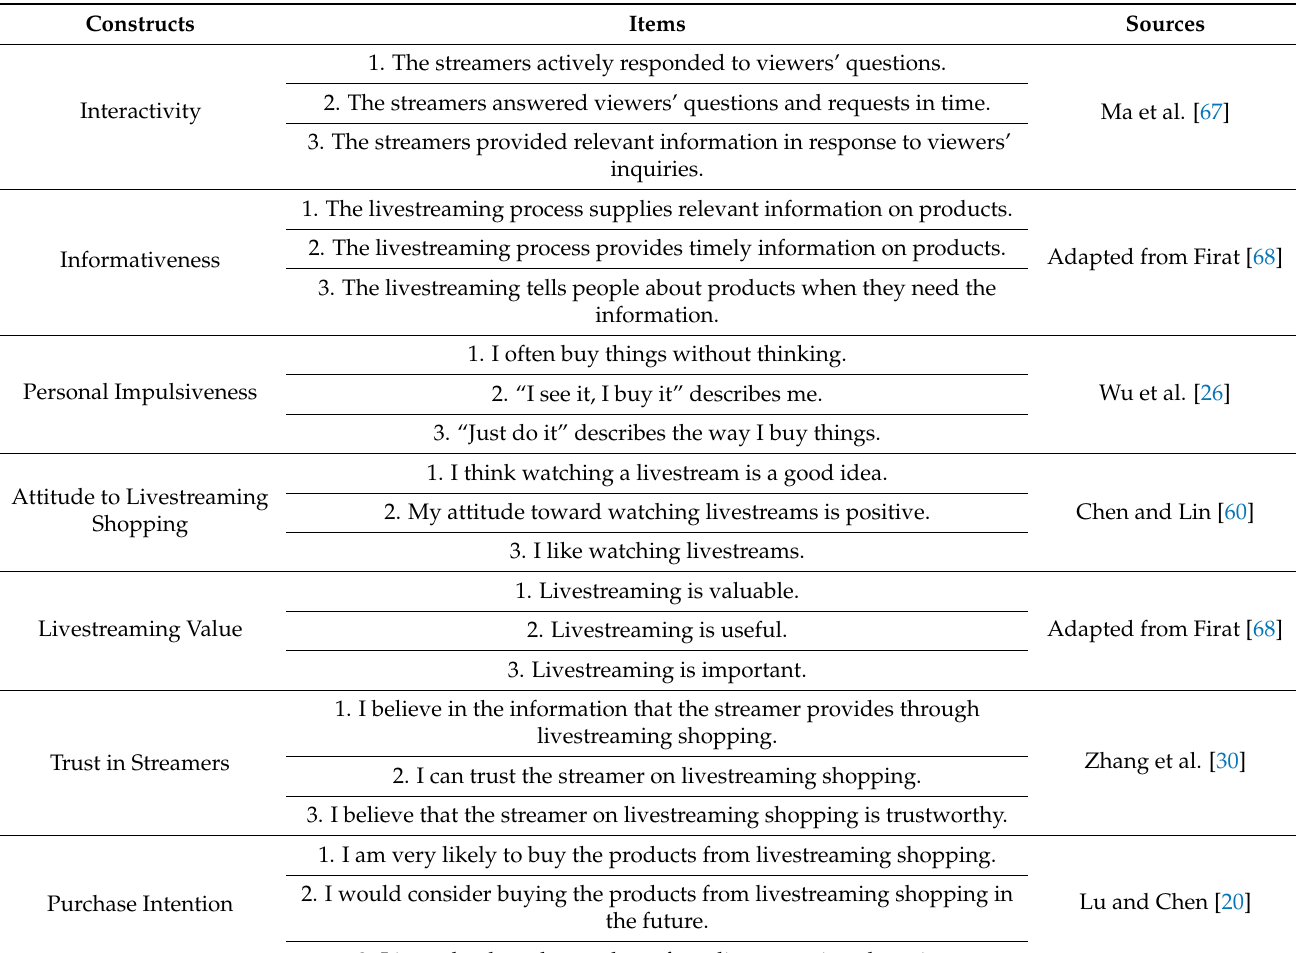
Table 2. Measurement items for the